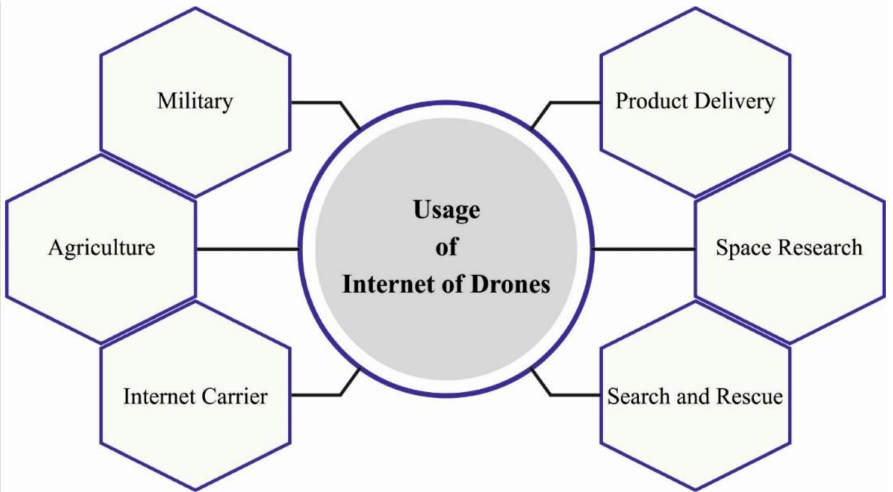
Figure 1. Application areas of